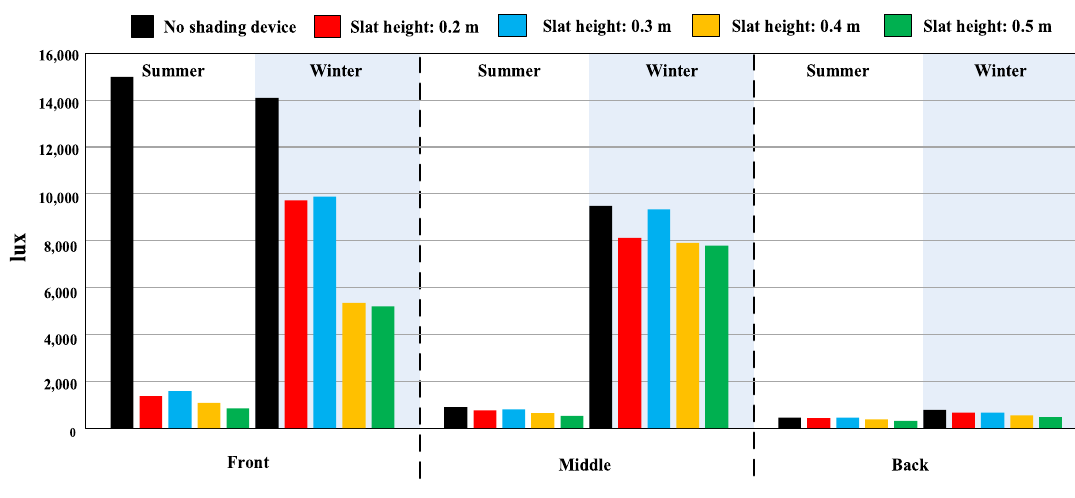
Figure 7. Daylighting performance through the egg-crate.